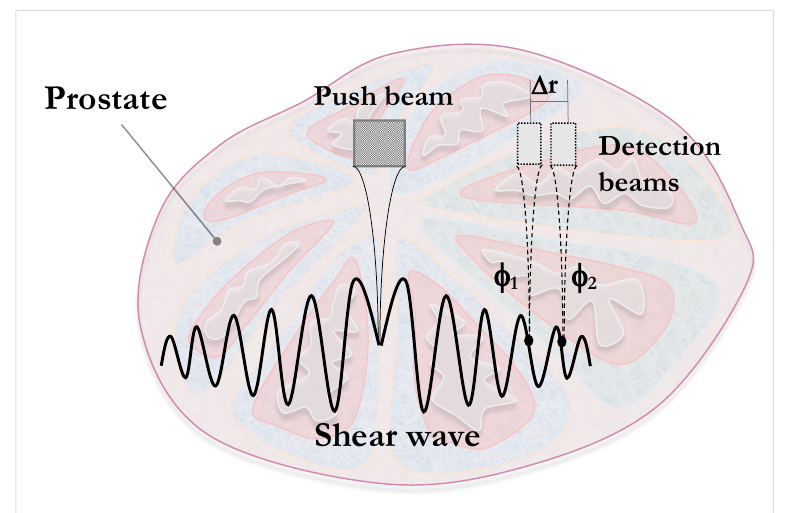
Figure 3. Illustration of shearwave dispersion ultrasound vibrometry (SDUV) principle. A harmonic shear wave is produced by a push beam; the propagation is monitored by separated detection